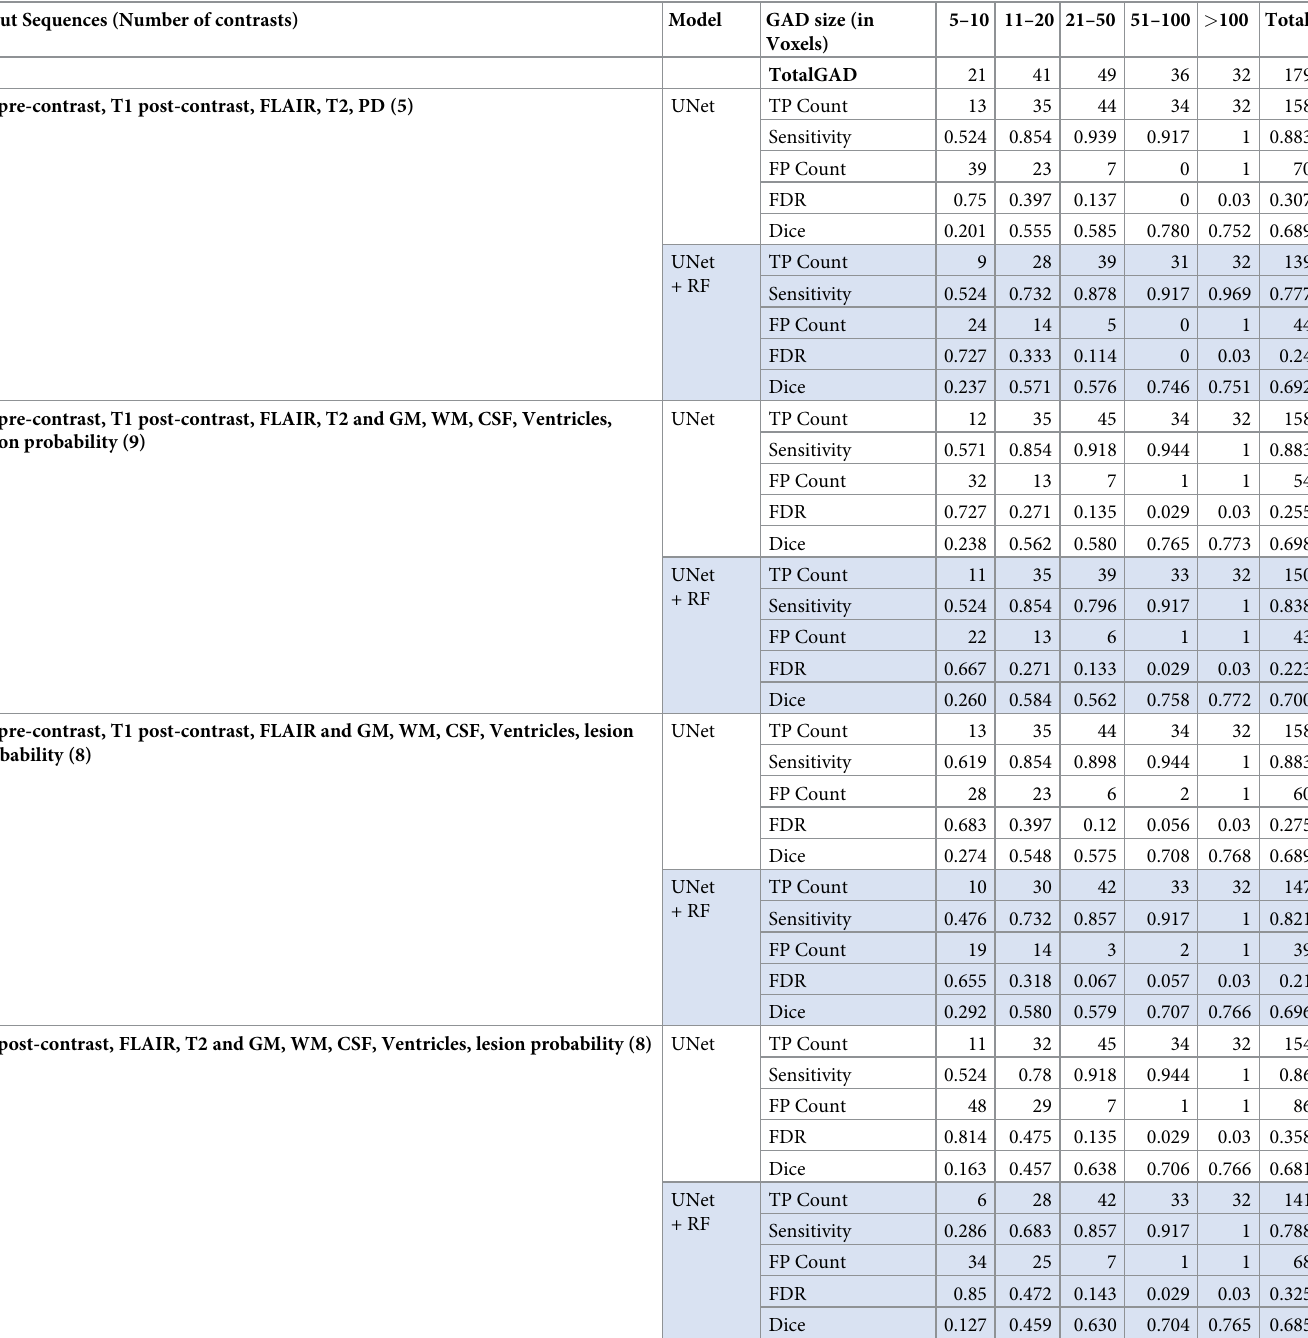
Table 4. Effect of different input combinations of MRI sequences from test cases of Dataset A. Input Sequences (Number of